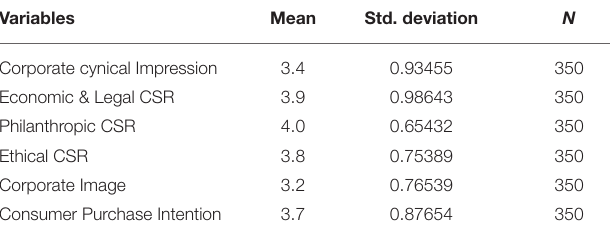
TABLE 2 | Descriptive